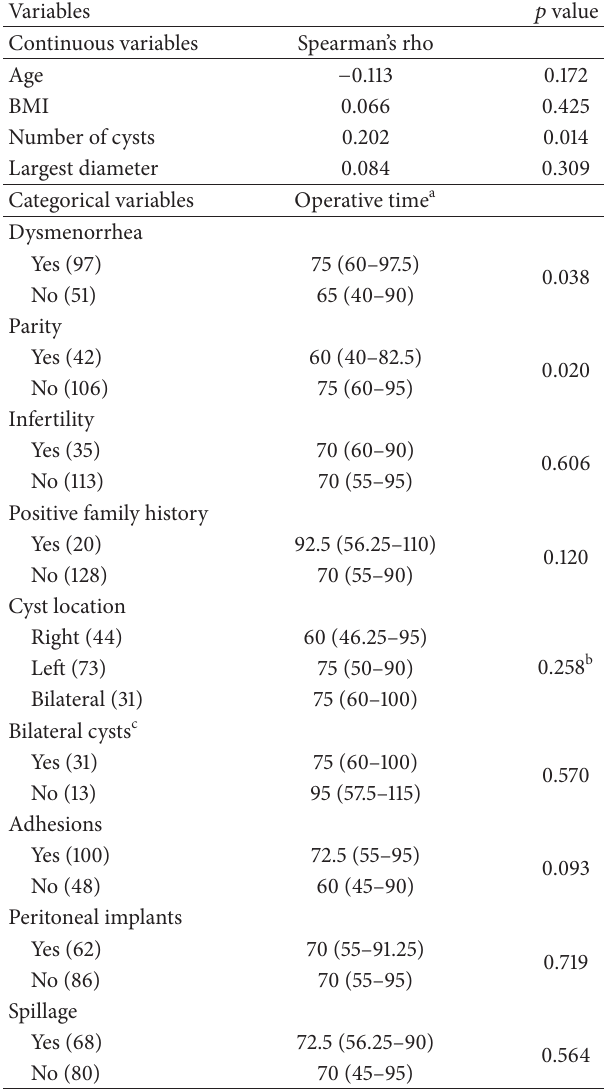
Table 1: Factors affecting the operative time of laparoscopic surgery for ovarian